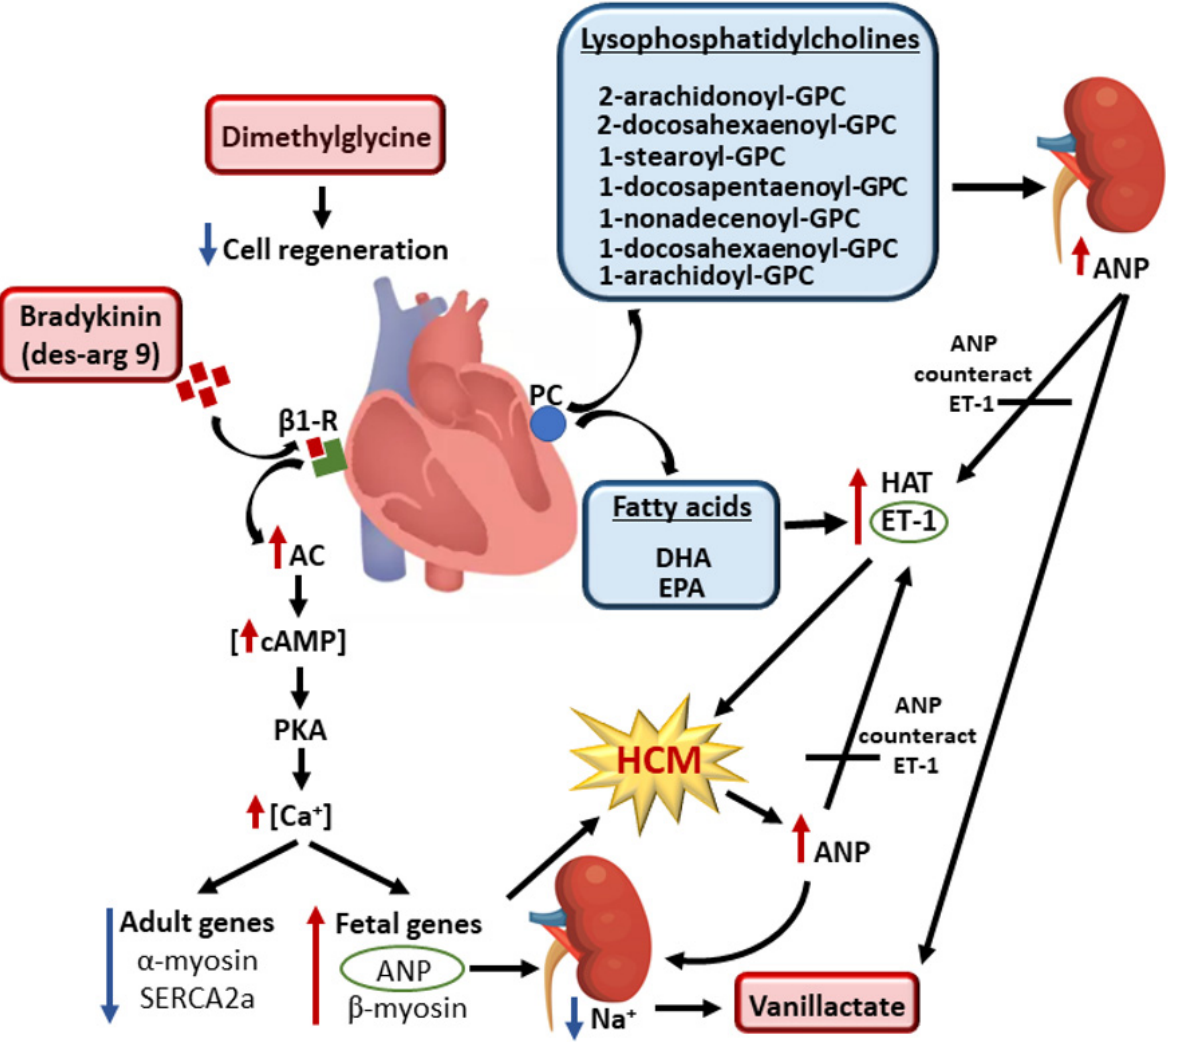
Figure 1. Metabolites involved in the cell signaling that regulates hypertrophy of cardiomyocytes in the carriers of pathogenic or likely pathogenic genetic variants for HCM. Red boxes indicate in- creased concentrations and blue boxes decreased concentrations of the metabolites in the carriers of genetic variants compared to the controls. Bradykinin activates β 1-receptors, resulting in high in- tracellular concentrations of calcium and suppression of adult and activation of fetal gene expres- sion. This leads to enhanced cardiomyocyte contractility, impaired relaxation, induced hypertrophic remodeling, and a release of ANP as a response to hemodynamic loading. Increased ANP concen- trations lead to an increase in sodium excretion, which increases vanillactate concentrations. Hy- drolysis of PC generates lysophosphatidylcholines (LPC) and fatty acids. A decrease in lysophos- phatidylcholine concentration increases ANP concentrations. Low concentrations of EPA and DHA activate HAT and ET-1, triggering hypertrophy of cardiomyocytes. Released ANP antagonizes ET- 1 and restores hemodynamic stability. Dimethylglycine impairs cell regeneration and contributes to